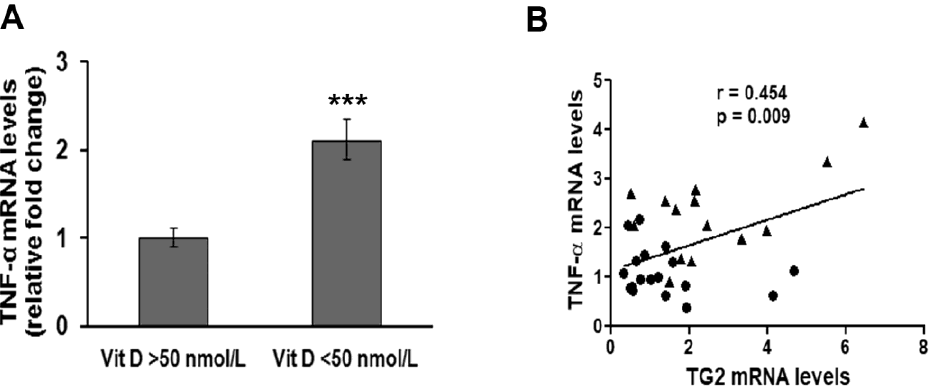
Figure 3. Assessment of TNF- α mRNA levels and correlation with TG2 mRNA levels in PBMC of individuals recruited for this study. ( A ) Quantitative Real-time PCR analysis of TNF- α mRNA levels after normalization against β -actin mRNA levels. *** p < 0.001, significant difference in comparison to individuals having normal vitamin D levels. ( B ) Plot showing results of correlation analysis between TG2 and TNF- α mRNA levels in the study cohort. ● subjects having normal vitamin D levels; ▲ subjects having deficient vitamin D levels. p = 0.009, statistically significant difference according to a p value <0.05.